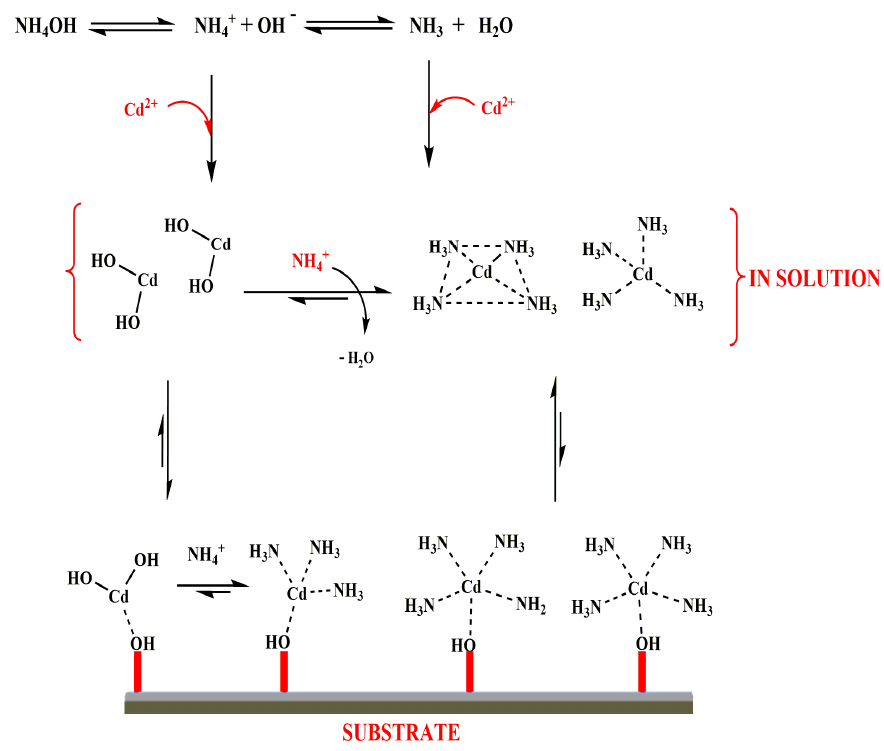
Figure 11. The formation of intermediate cadmium complexes and their connections.